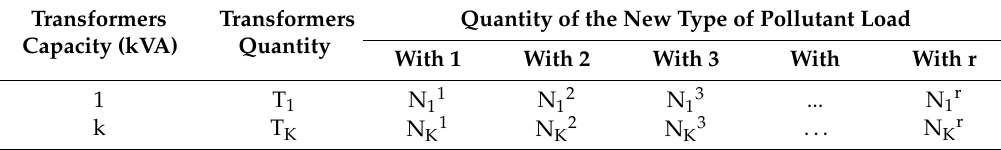
Table 1. Subsystem characterization with a new type of polluting